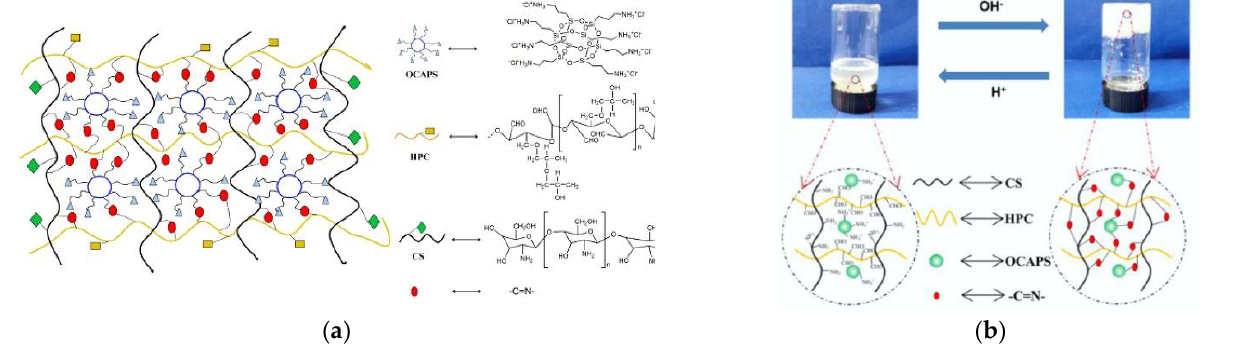
Figure 31. Structure of CS/HPC/POSS hydrogels ( a ) and their pH responsivity ( b ). Reprinted from React. Funct. Polym. 2021, 158 , Zhang, X.; Meng, Y.; Shen, W.; Dou, J.; Liu, R.; Jin, Q.; Fang, S., pH-responsive injectable polysaccharide hydrogels with self-healing, enhanced mechanical properties based on POSS, 104773, [102] Copyright (2021), with permission from Elsevier.